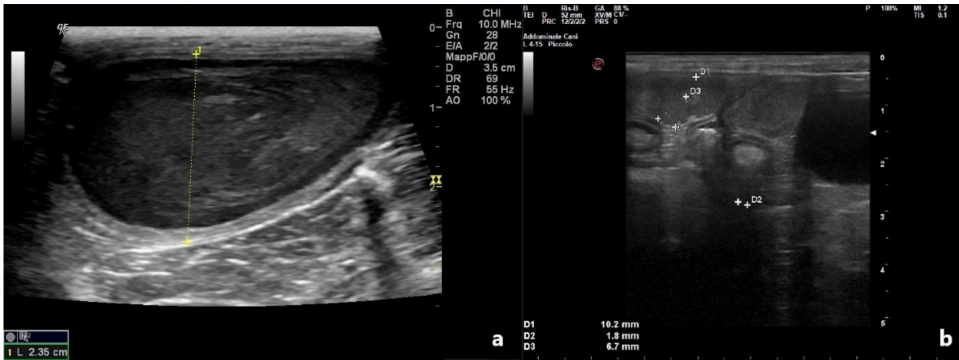
Figure 1. Ultrasonographic appearance of affected uterus, at the time of diagnosis. Uterine content has a heterogeneous echotexture. ( a ) Patient 2; ( b ) Patient 4.